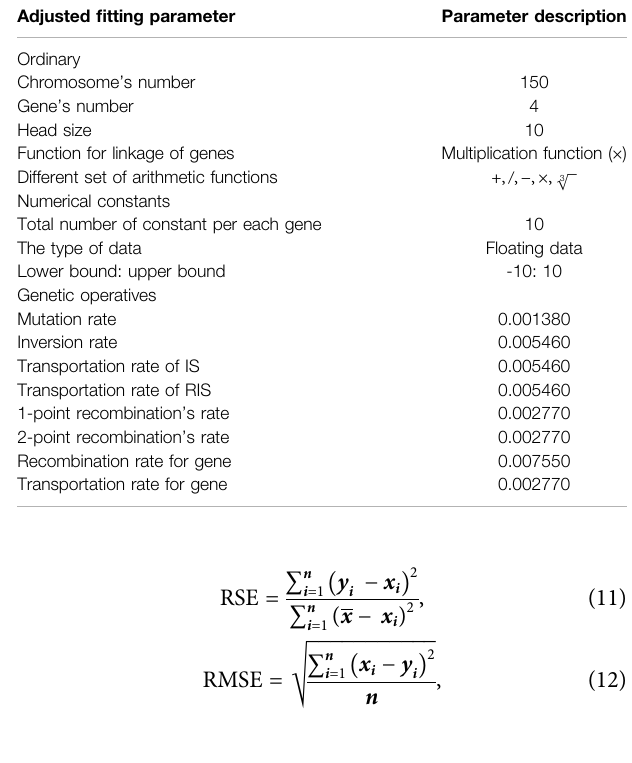
TABLE 4 | Setting of fi tted parameters for the GEP model.